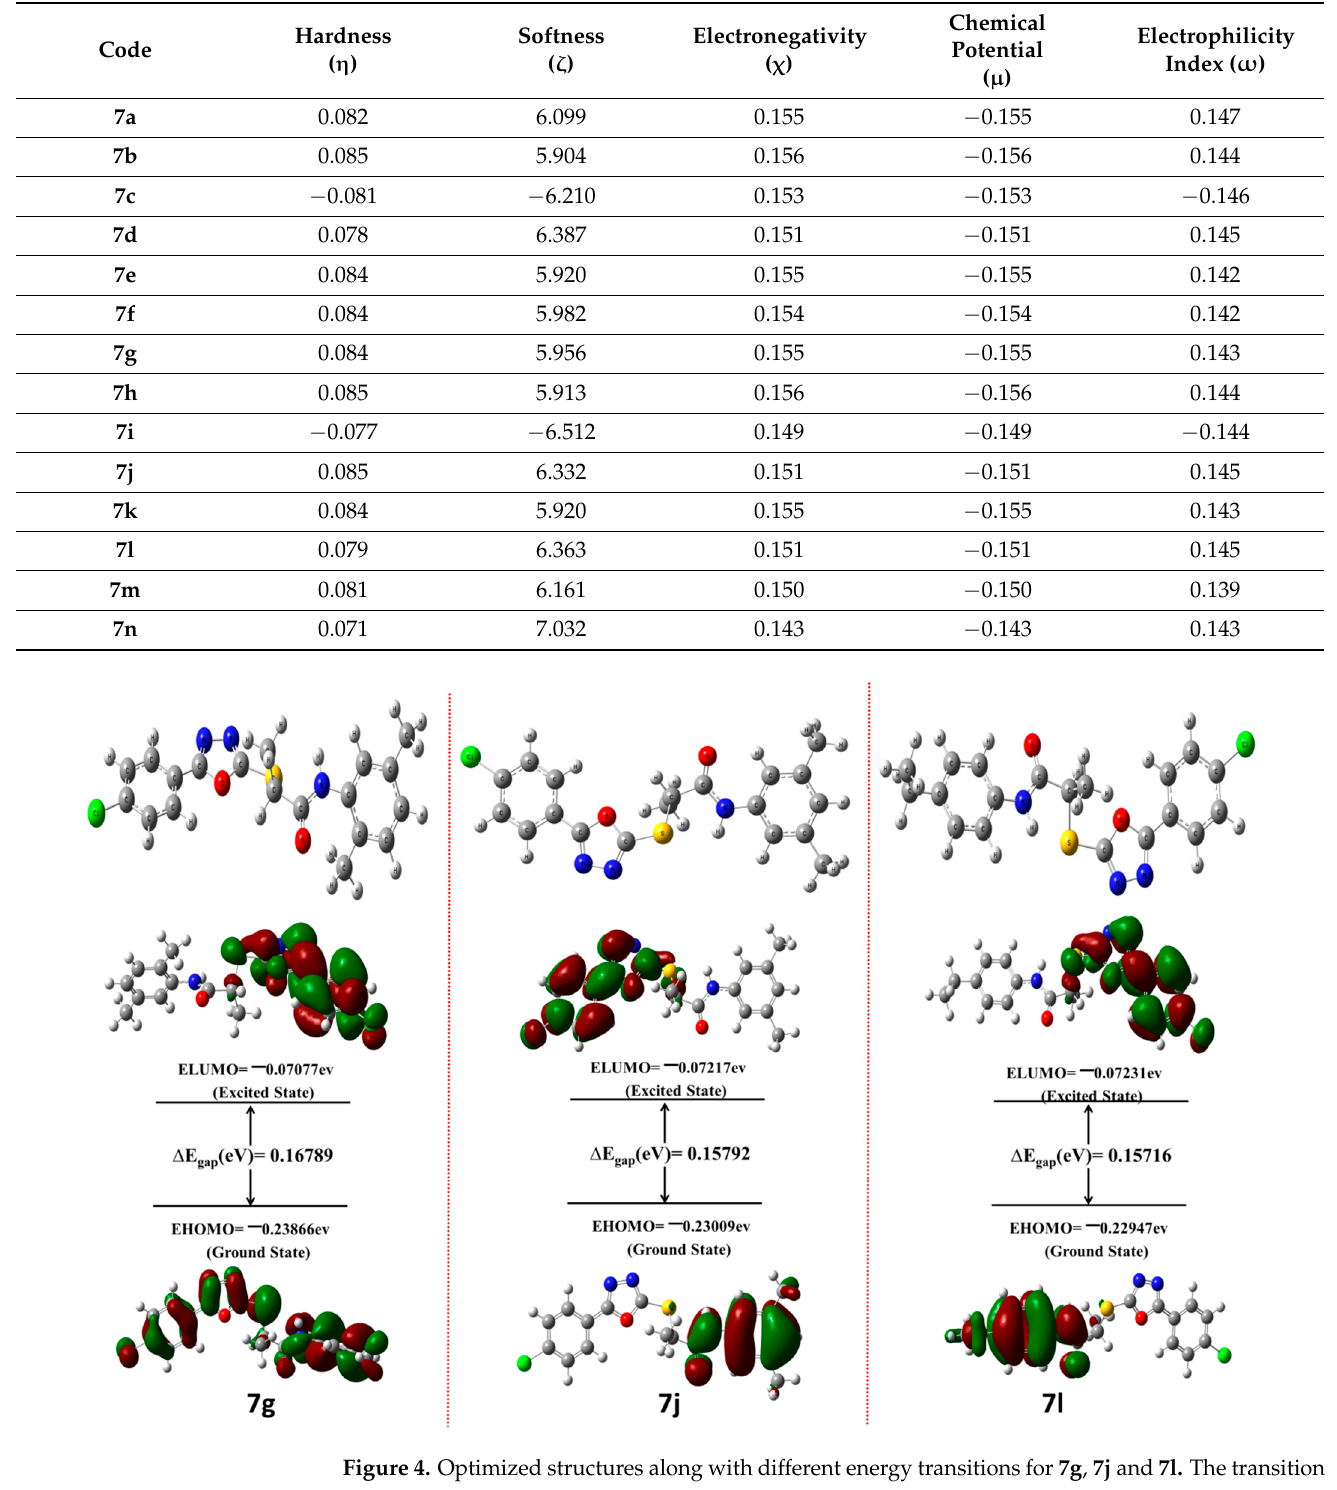
Table 3. Chemical properties including softness and hardness values of selected compounds.